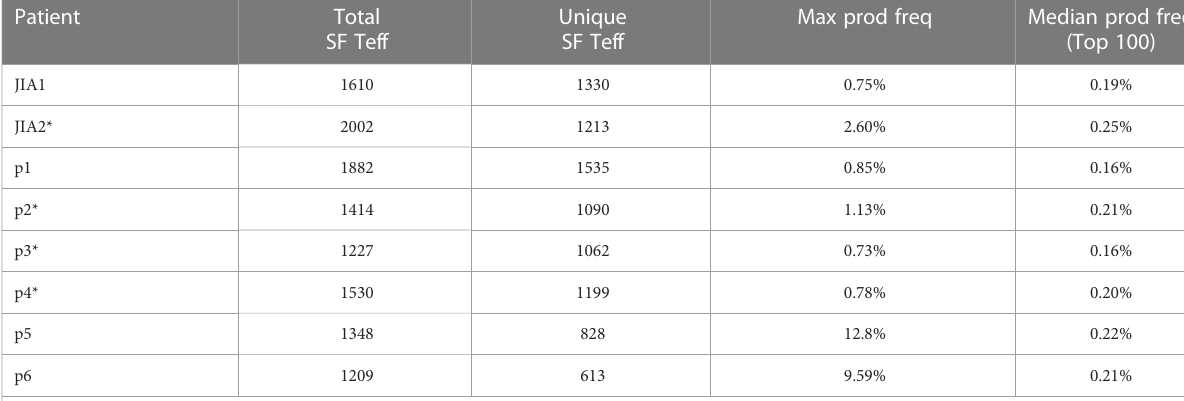
TABLE 2 Key TCR repertoire metrics from single-cell transcriptomics analysis of SF Teffs. Patient Total